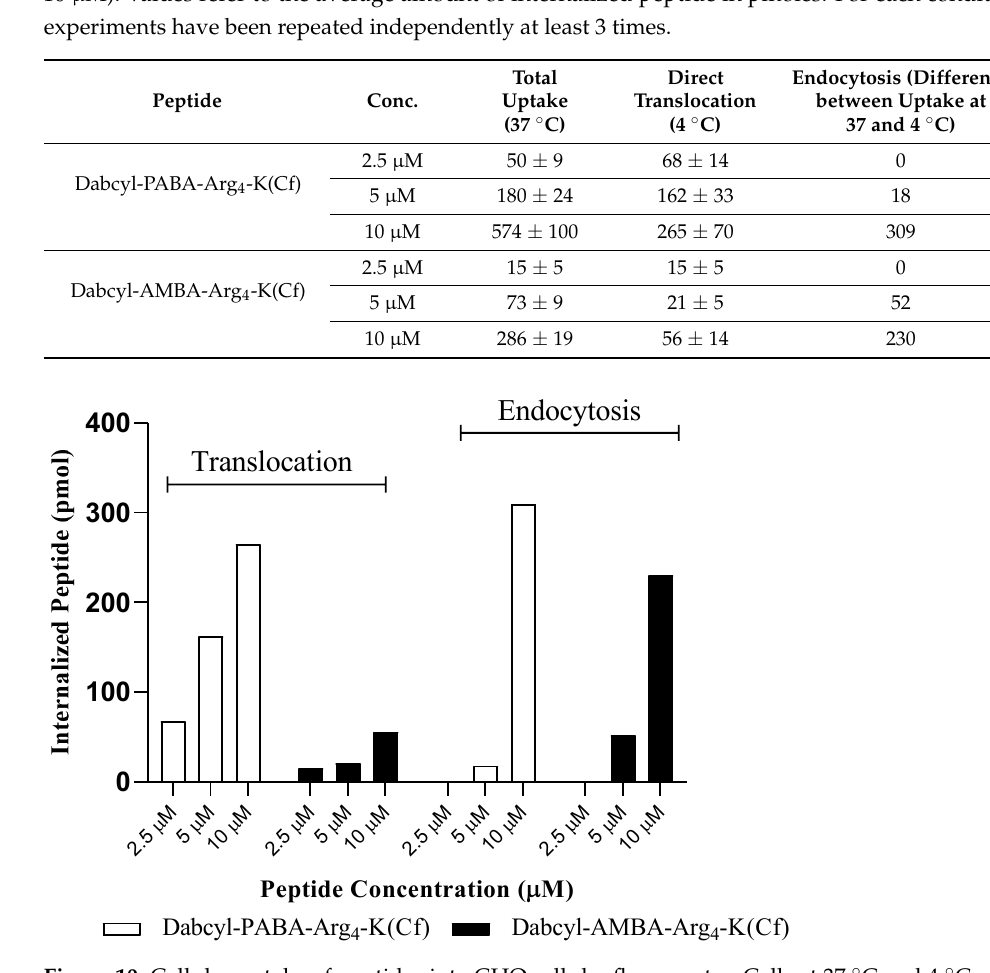
Figure 10. Cellular uptake of peptides into CHO cells by fluorometry. Cells at 37 °C and 4 °C were treated for 1 hr with concentrations 2.5, 5 and 10 µM. Cells were lysed with Tris 50mM, NP-40 1%, NaCl 1M and trypsin before fluorescence was measured ( λ ex = 494 nm and λ em = 510-560 nm).